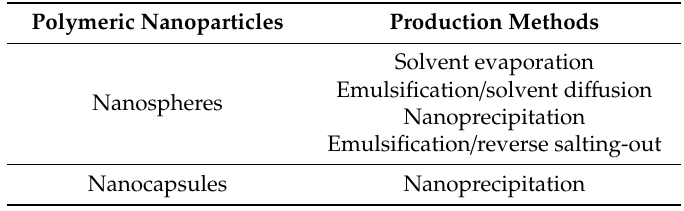
Table 2. Di ff erent methods for the production of polymeric nanoparticles.